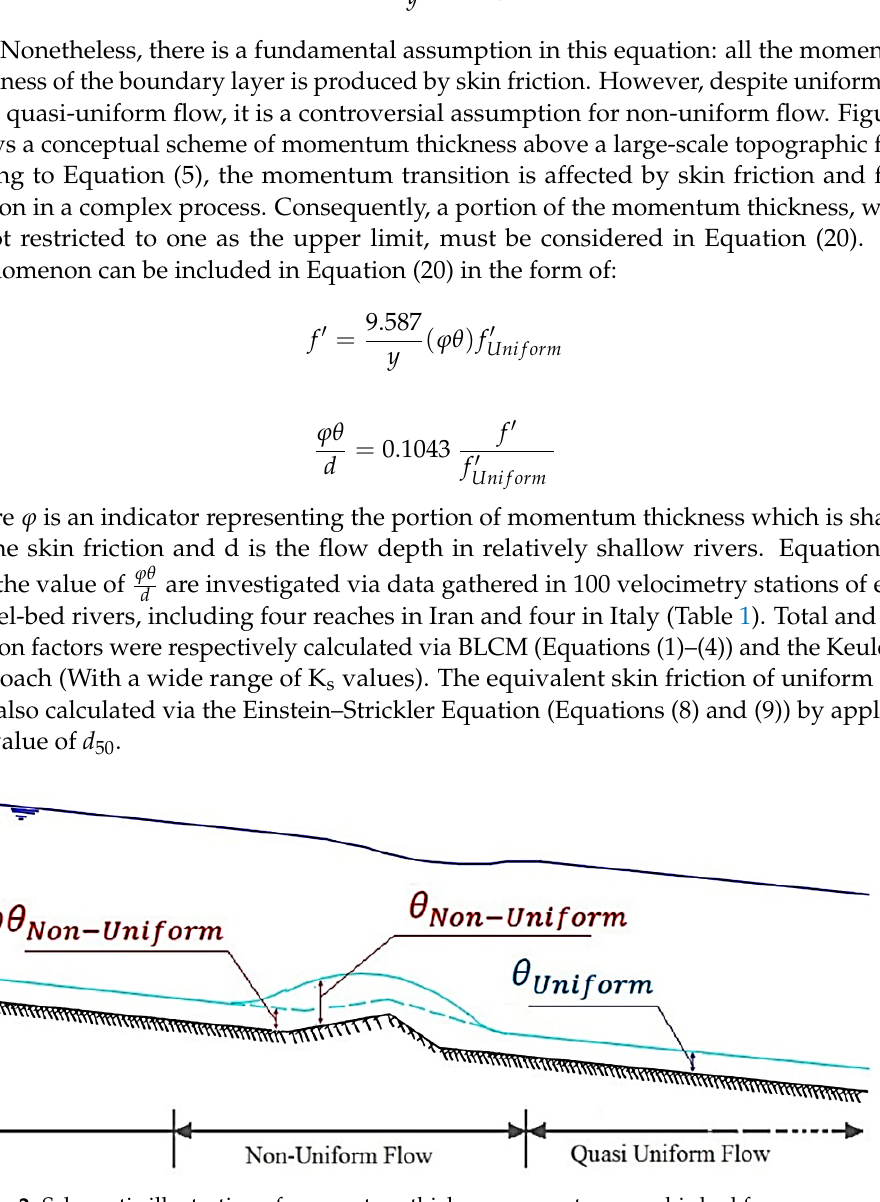
Figure 2. Schematic illustration of momentum thickness near a topographic bed form.